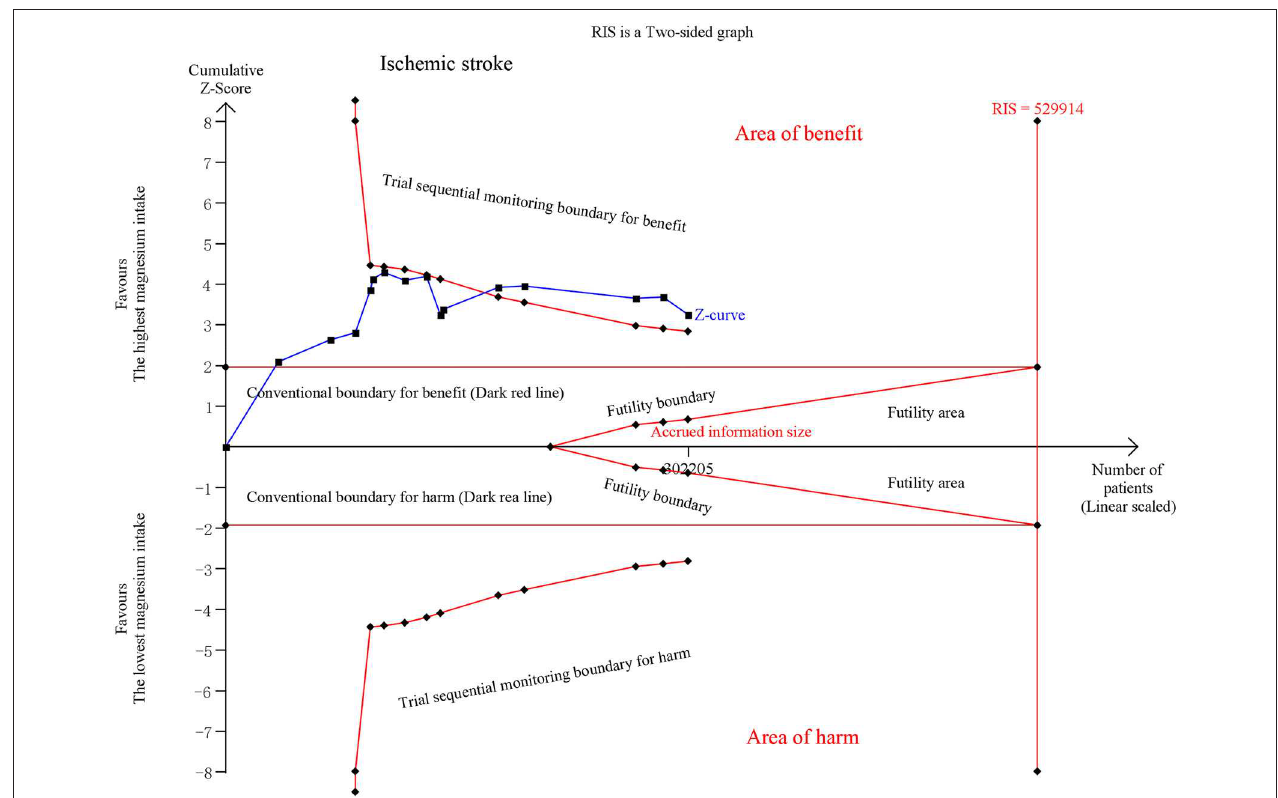
FIGURE 3 | Trial sequential analysis of ischemic stroke comparing the highest magnesium intake category to the